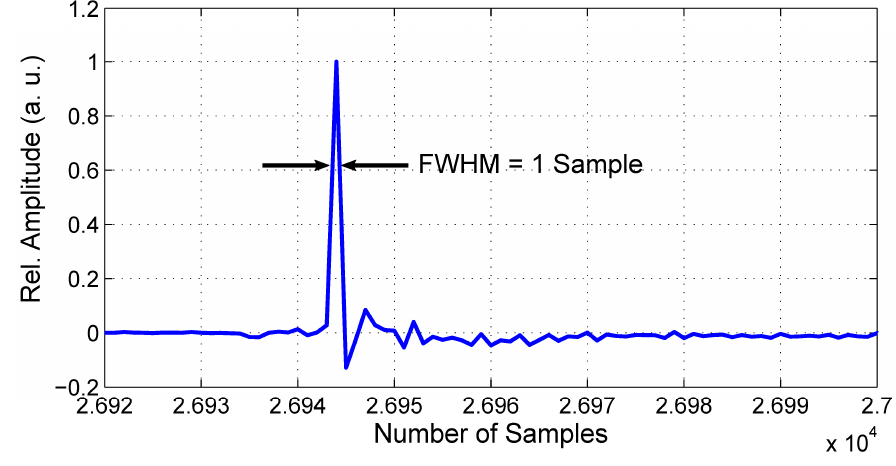
Figure 7. SoC closed-loop impulse response (pulse detail).